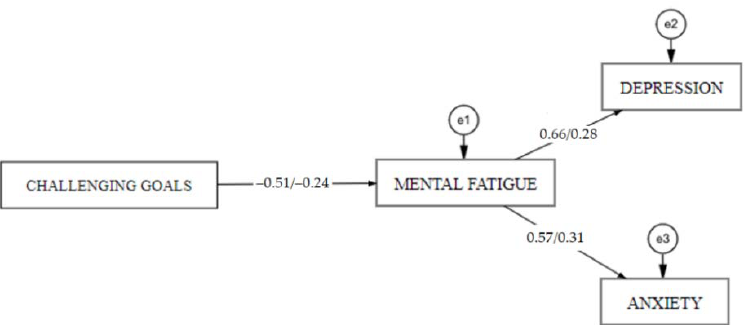
Figure 4. Alternative path diagrams (challenging goals, mental fatigue, depression, and anxiety) in groups of participants and non-participants in e-learning-based computer programming courses. Table 18. Results of structural equation modelling of challenging goals, mental fatigue, depression, and anxiety in groups of participants and non-participants of e-learning-based computer programming